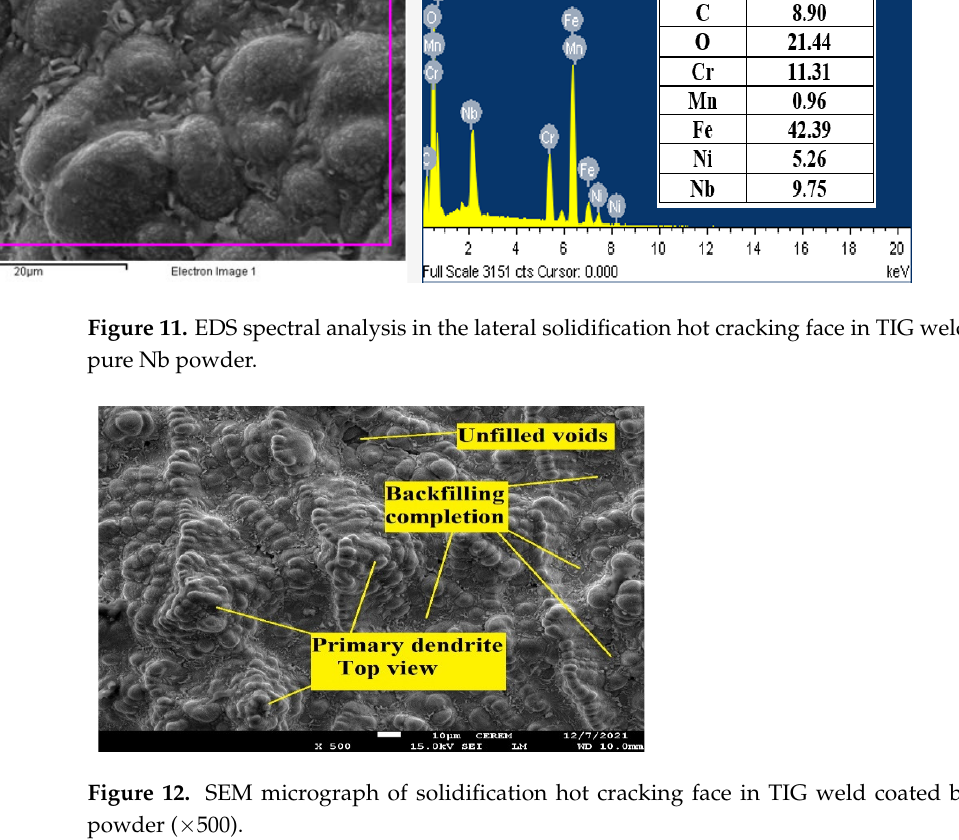
Figure 11. EDS spectral analysis in the lateral solidification hot cracking face in TIG weld coated by pure Nb powder.